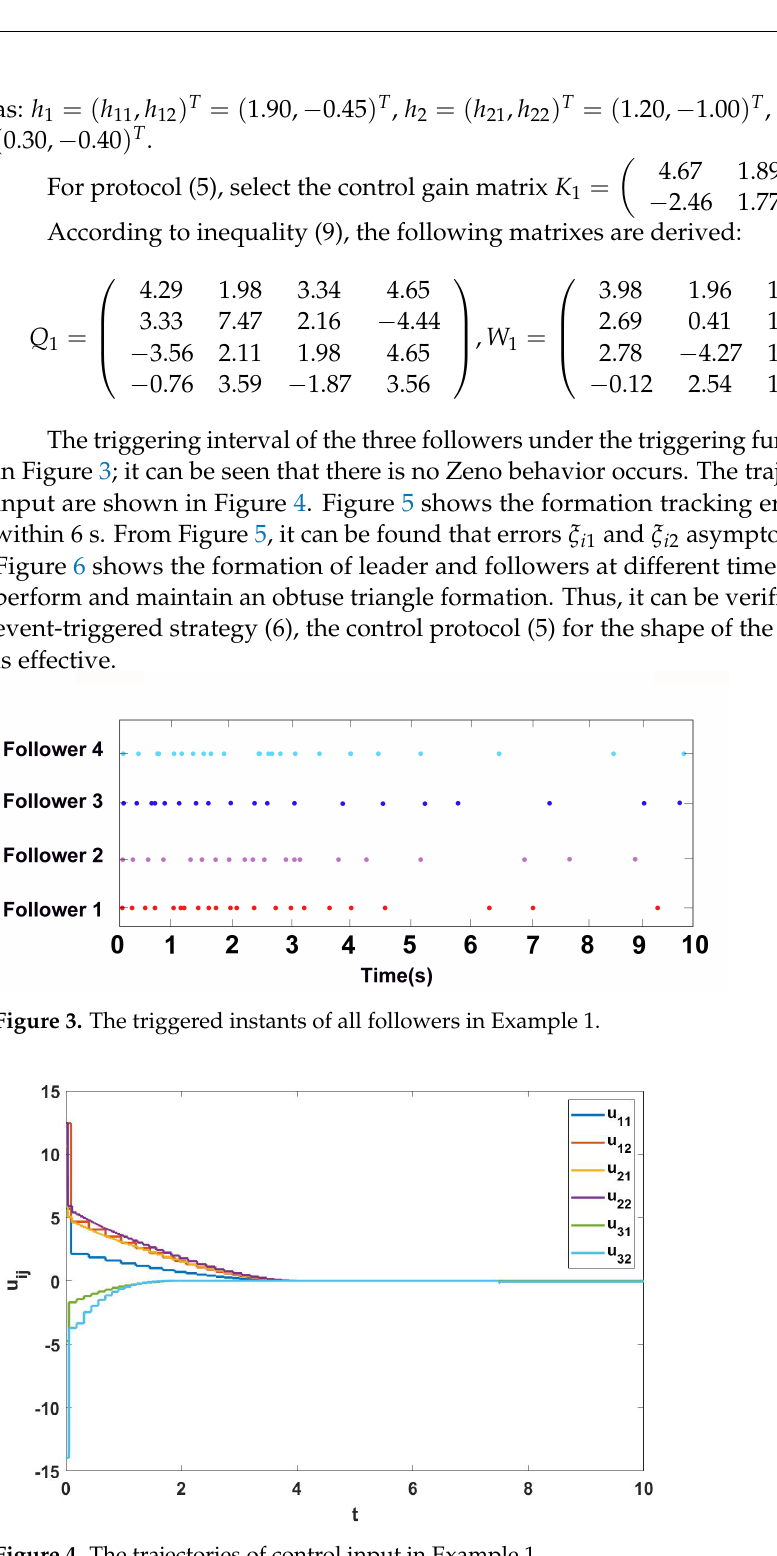
Figure 4. The trajectories of control input in Example